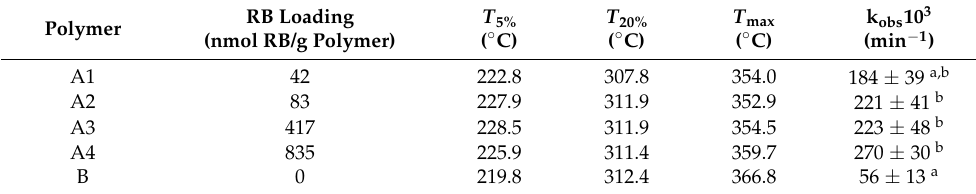
Table 1. Thermal properties of films A1 – A4 and B determined by TGA, and observed kinetic con- stant (average of three measurements) of the reaction of DMA with 1 O 2 generated by irradiation of the films.